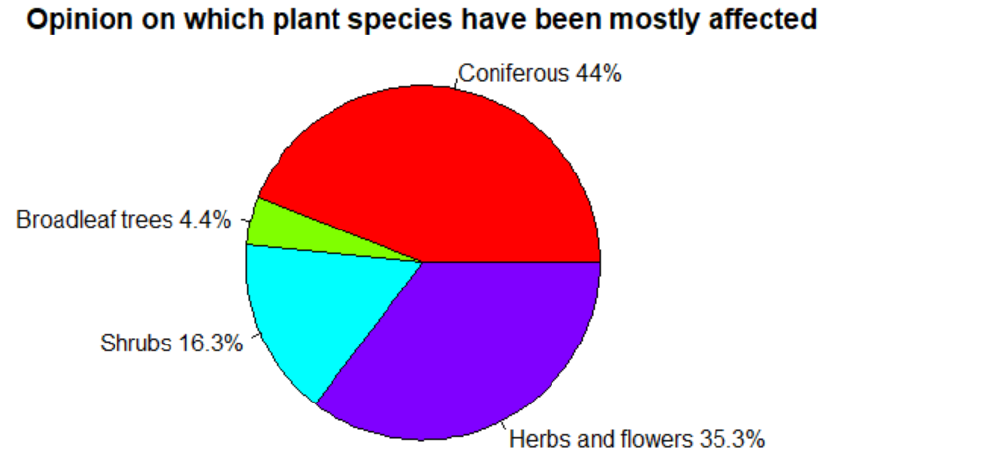
Figure 6. Answers of Question: In Cypriot Forests, which the plant species according to your opinion, has been mostly affected due to climate change?—Figure 1 is a map depicting the location of those forested areas.